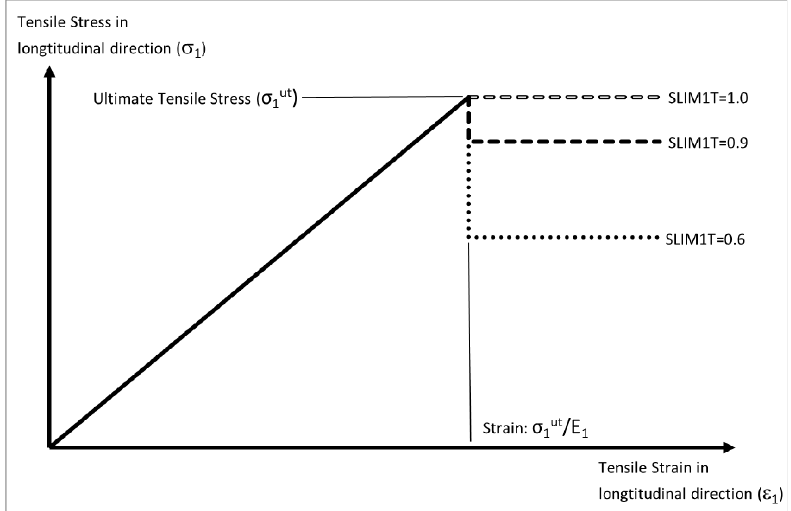
Figure 6. Effect of Slim factor (shown for longitudinal direction).